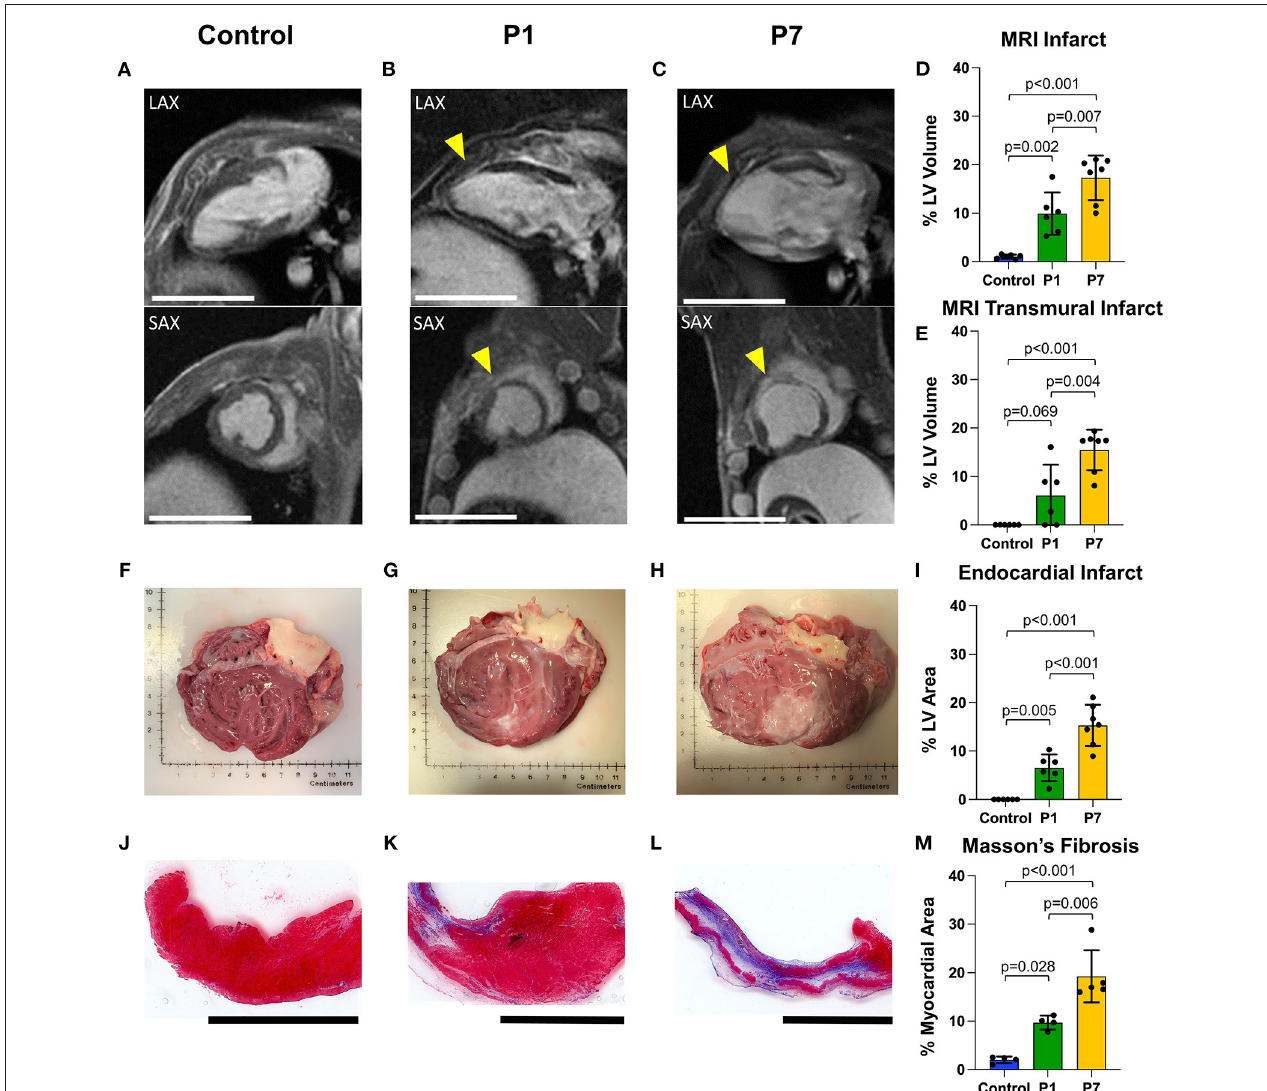
FIGURE 3 | Piglets exhibit reduced scar formation after myocardial infarction on postnatal day 1. At 7 weeks after myocardial infarction (MI), cardiac magnetic resonance imaging (MRI) with late gadolinium enhancement was performed to evaluate left ventricular (LV) fibrosis. Representative long-axis (LAX) and short-axis (SAX) views are presented for (A) healthy controls, (B) pigs receiving MI on postnatal day 1 (P1), and (C) pigs receiving MI on postnatal day 7 (P7). Infarcted areas are marked by yellow arrows. Scale bars, 5cm. (D) Compared to P7 pigs, P1 pigs developed significantly smaller infarcts, including (E) significantly smaller transmural infarcts. (F–H) Following heart explant, the LV endocardium was assessed for visible scar formation, revealing (I) significantly smaller endocardial scar in P1 pigs compared to P7 pigs. (J–L) Masson’s trichome staining was performed to confirm the presence of fibrotic scar. Scale bars, 1cm. (M) Significantly less fibrotic content was observed in P1 pigs compared to P7